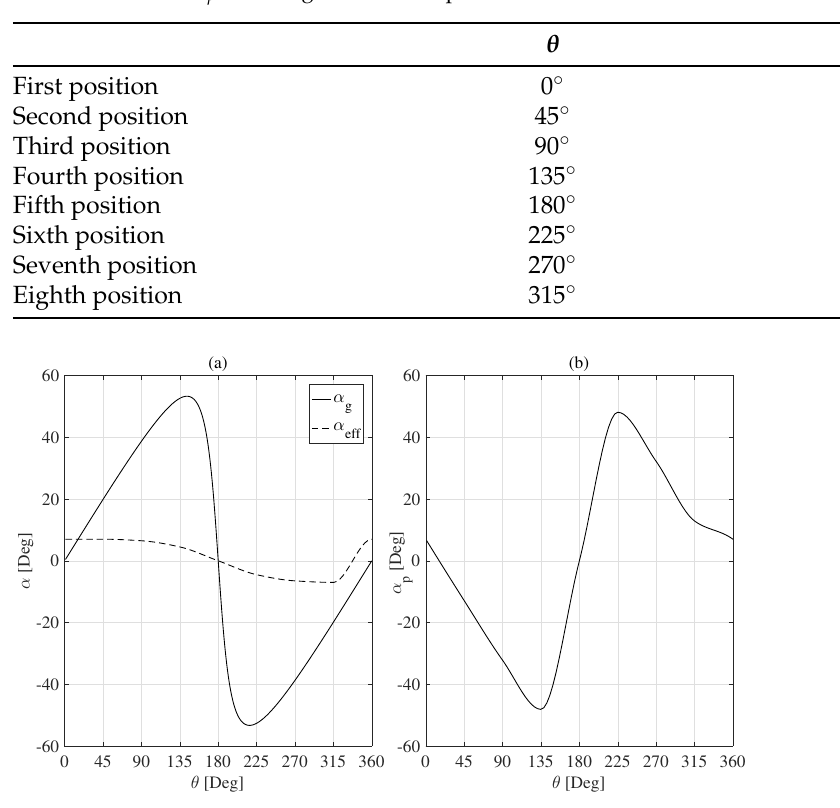
Table 5. Values of α p at the eight azimuthal positions.